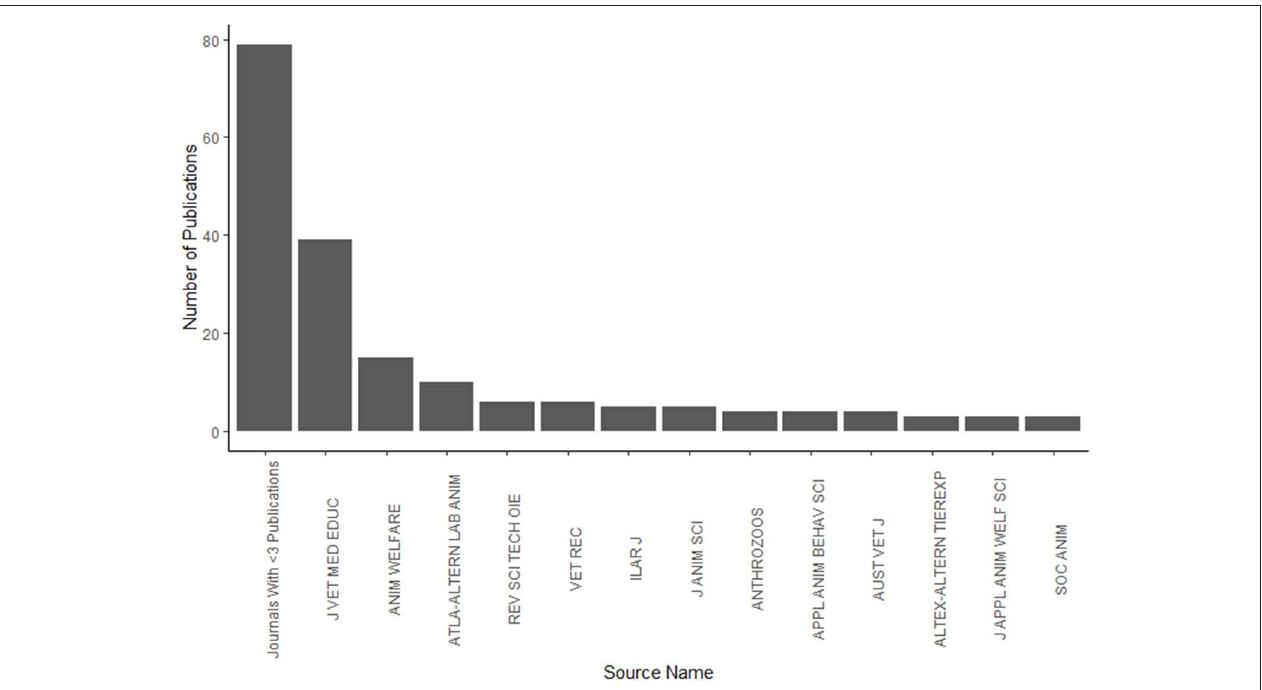
FIGURE 3 | Frequency of lemmatised words present in 188 abstracts regarding animal welfare